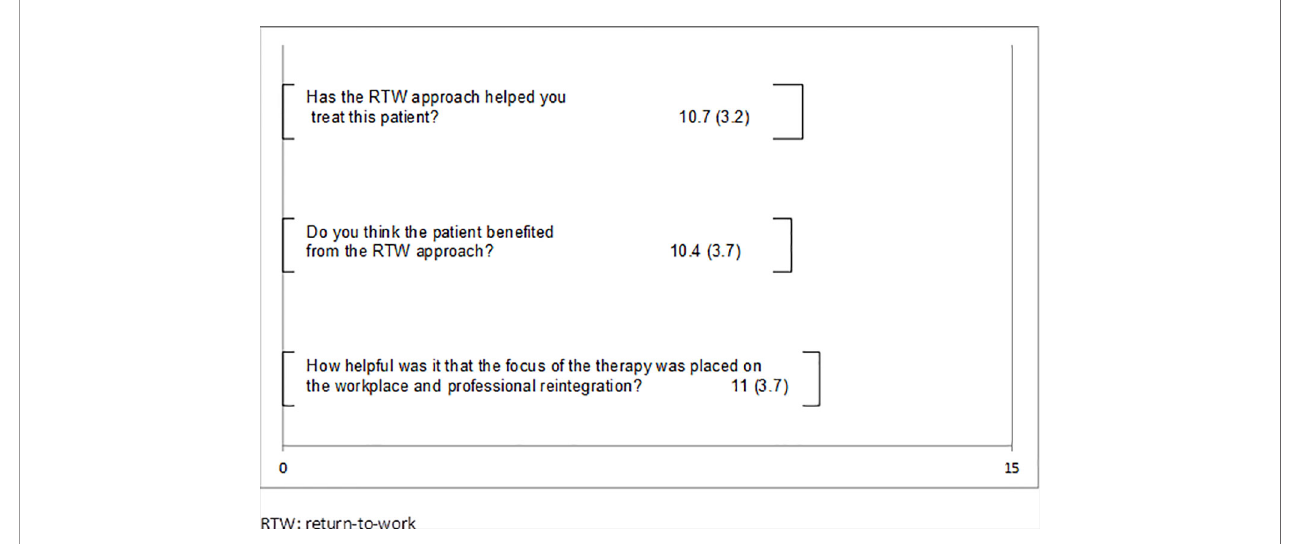
FIGURE 2 | Results of the acceptability questionnaire in therapists.